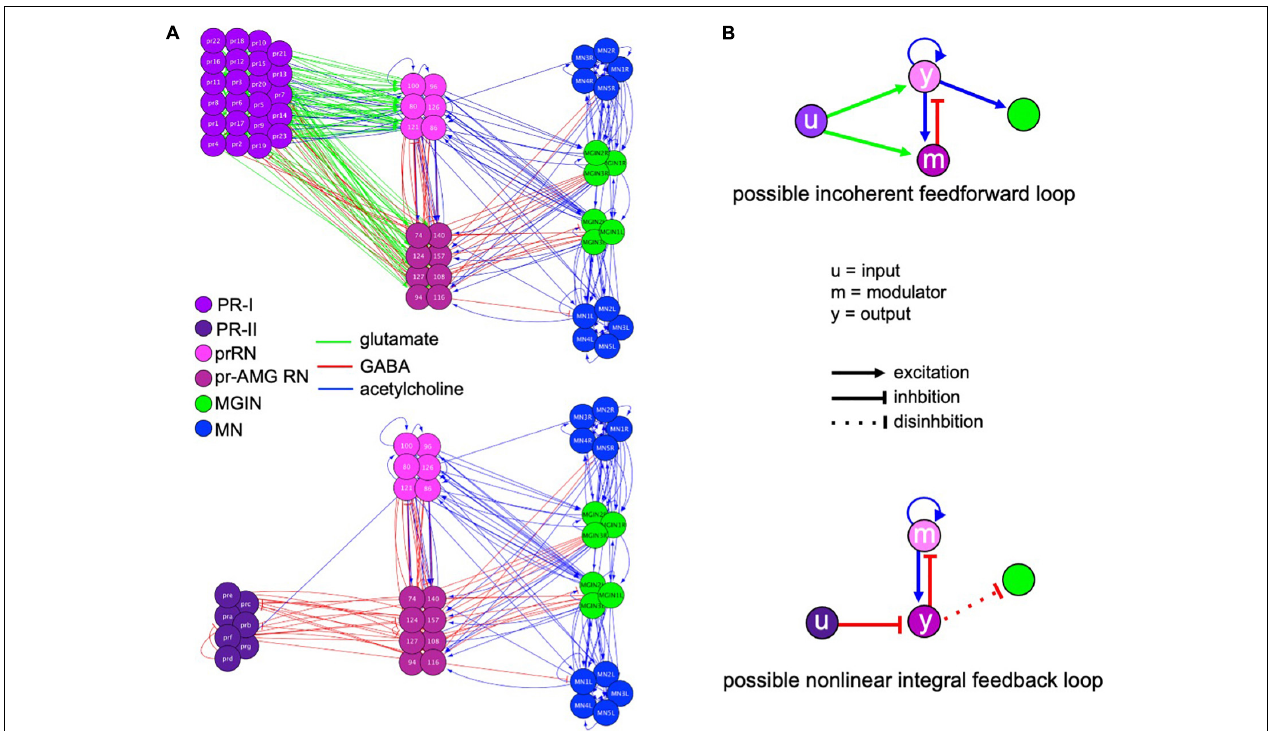
FIGURE 6 | Visuomotor circuits and putative fold change detection circuits. (A) Full circuits for the PR-I (top) and PR-II (bottom) pathways from the Ciona connectome (Ryan et al., 2016). Neurotransmitter use for synaptic connections (lines) is based on Kourakis et al. (2019). PR, photoreceptor; prRN, photoreceptor relay neuron; pr-AMG RN, photoreceptor ascending motor ganglion relay neurons; MGIN, motor ganglion interneurons; MN, motor neurons. (B) Simplified circuits for the PR-I (top) and PR-II (bottom) pathways derived by combining like cells and assigning valence of synapses (excitatory or inhibitory) based on consensus for that cell type. Nodes are labeled according to the proposed function (i.e., input modulator, and output). Colors of neuron classes are according to Ryan and Meinertzhagen